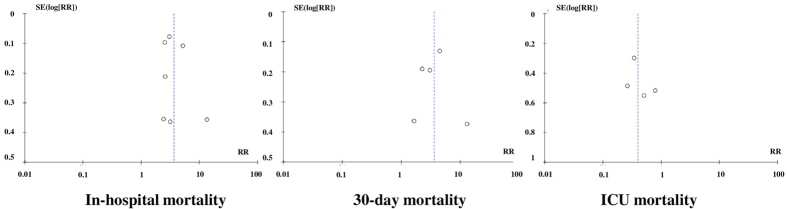
Funnel plots for in-hospital mortality, 30-day mortality and ICU mortality.